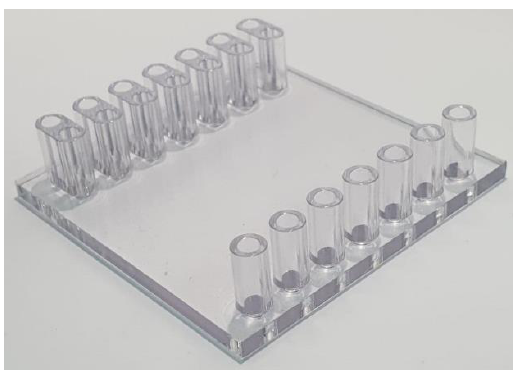
Figure 9. A cover plate with inlet and outlet ports machined by mechanical milling and drilling using polycarbonate block.